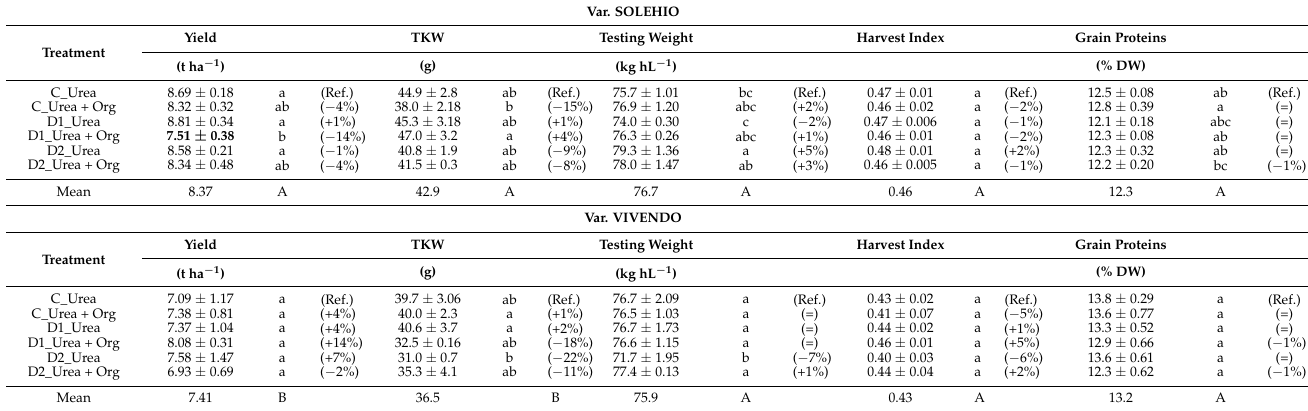
Table 3. Grain quantitative and qualitative parameters (means ± S.E.; n = 3) in the wheat varieties Solehio (A) and Vivendo (B) following the biofortification treatment with D1 and D2 doses of Ca + Mg + K, applied with urea (Urea) and urea + organic (Urea + Org) nitrogen fertiliser, and in the two controls C_Urea and C_Urea + Org. TKW: thousand kernel weight; DW: dry